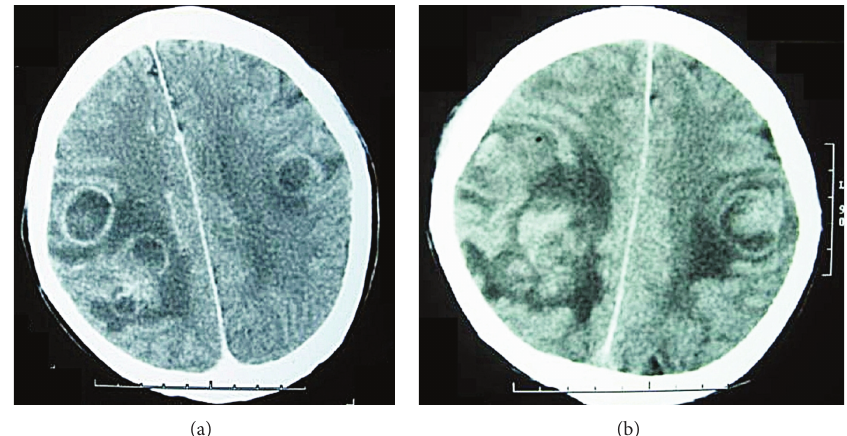
Figure 3: (a) Brain CT with contrast enhanced showed multiple solitary abscesses over right temporal and bilateral frontal, parietal area with brain edema on April 2, 2002. (b) Brain CT on April 9, 2002, found severe brain edema even under the mannitol and dexamethasone